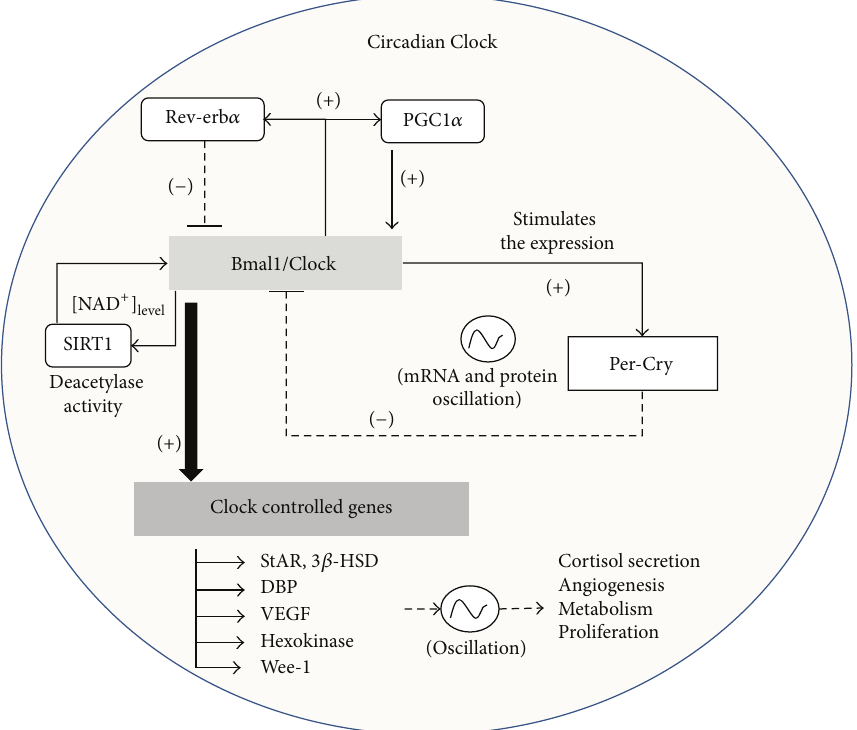
Figure 1: Circadian Clock. Positive regulation of clock genes Bmal1 and Clock stimulates promoter of negative regulators Per1–3 , Cry 1-2, and controlled clock genes StAR, 3 𝛽 -HSD, DBP, VEGF, Hexokinase, and Wee-1. Moreover, the molecular clock regulates the deacetylase activity of SIRT1 by regulation of NAD + /NADH